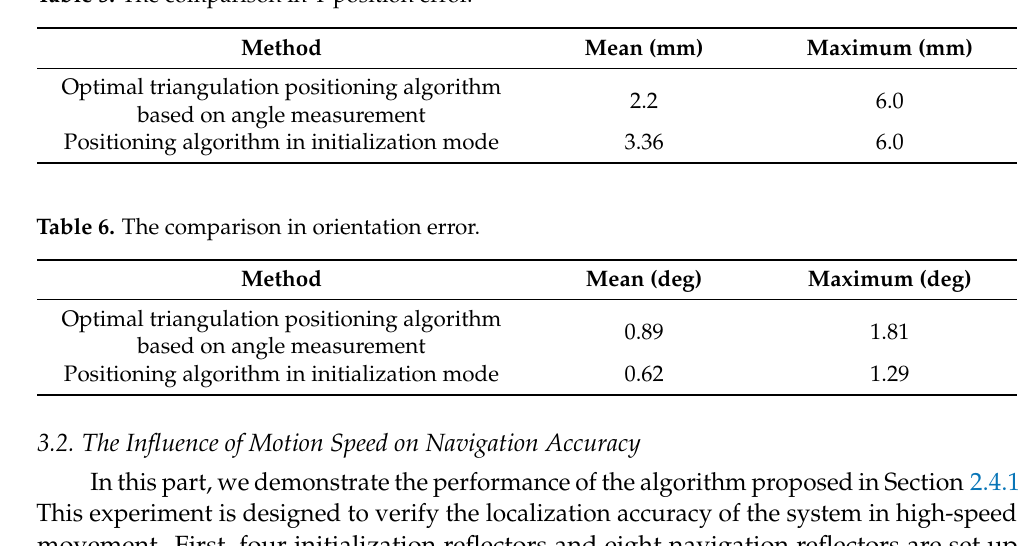
Table 5. The comparison in Y position error.